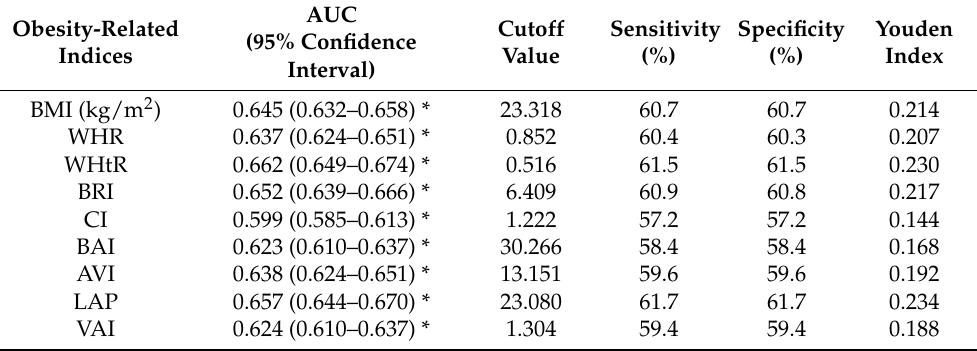
Table 6. Area under curve (AUC), cutoff value, sensitivity, specificity, and Youden index of nine obesity-related indices in male participants.